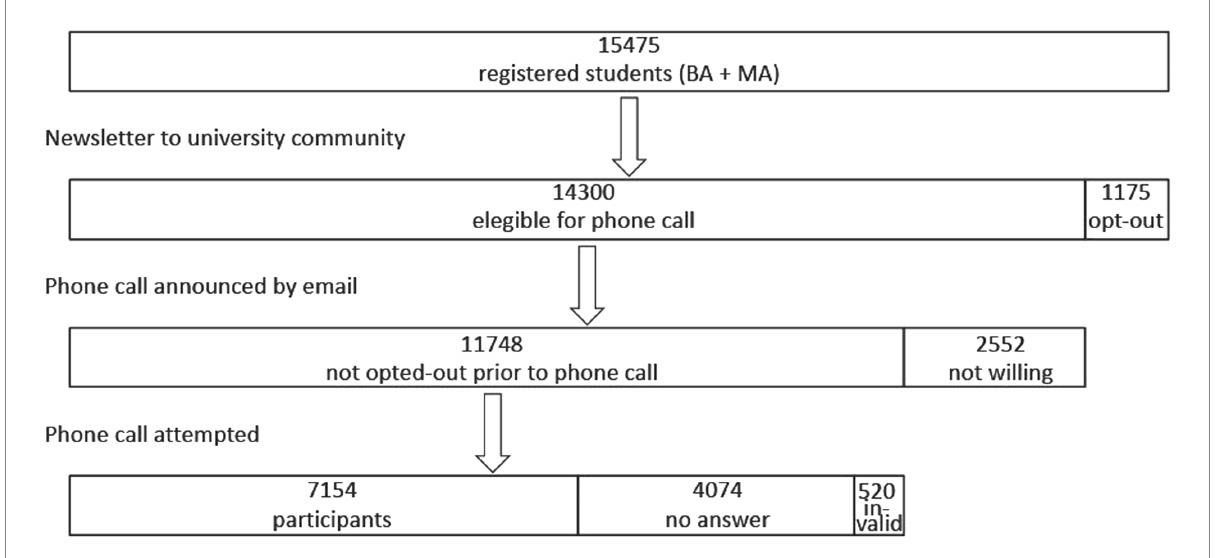
FIGURE 1 Flowchart of the sample. The monthly VUB newsletter which is also sent to all bachelor and master students registered at the Vrije Universiteit Brussel announced the phone call initiative. Students could opt out via an external link or by sending an email. Those who did not opt out were eligible for a phone call. These students were contacted by email, saying they would be called for a telephone interview. Some students replied to this mail, saying they were not willing to participate. Next, a phone call was attempted to the remaining 11,748 students. In the end there were 7,154 participants, 4,074 did not answer (three attempts), and 520 phone numbers were